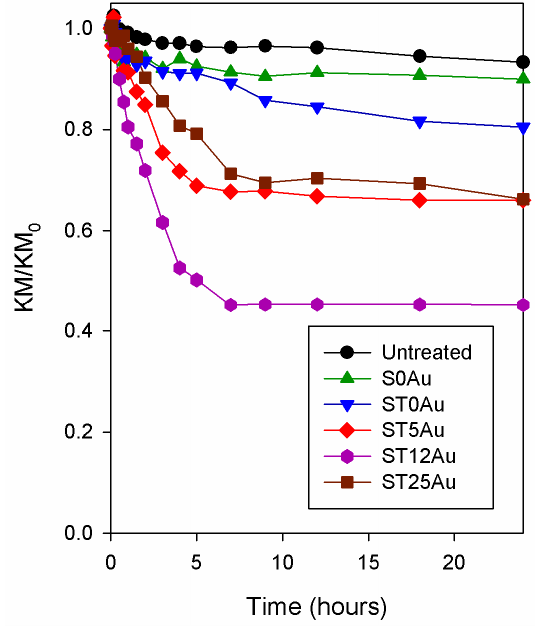
Figure 12. Evolution of KM/KM 0 for the untreated and treated stones stained with soot.